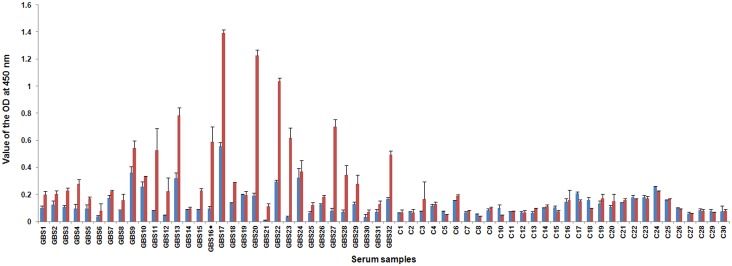
Anti-LOS IgG antibodies.Reactivity between the LOS extracted from C. jejuni ICDCCJ07001 and ICDCCJ07002 and the IgG antibodies in the sera from 32 GBS patients and 30 controls. The IgG antibodies in the sera from the GBS patients had stronger reactions with the LOS from C. jejuni ICDCCJ07002 than with the LOS from strain ICDCCJ07001 (the x-axis indicates the ID of the serum samples and the y-axis indicates the value of the OD at 450 nm; red bar for anti-07002 LOS reaction and blue bar for anti-07001 LOS reaction. The first 32 serum samples were from GBS patients and the last 30 samples were used as controls, 15 from the diarrheal patients and 15 from the healthy subjects). The serum sample GBS16 (labeled with a black diamond) corresponds to the patient from whom C. jejuni ICDCCJ07001 was isolated.